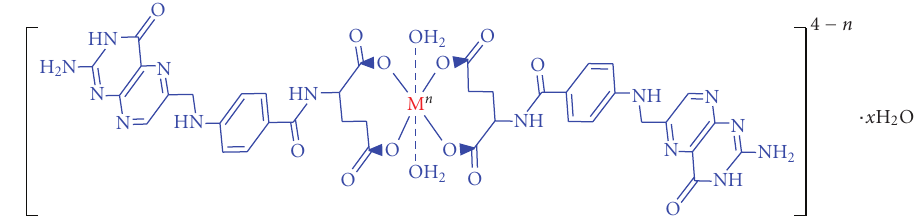
Figure 1: Structure of folic acid.